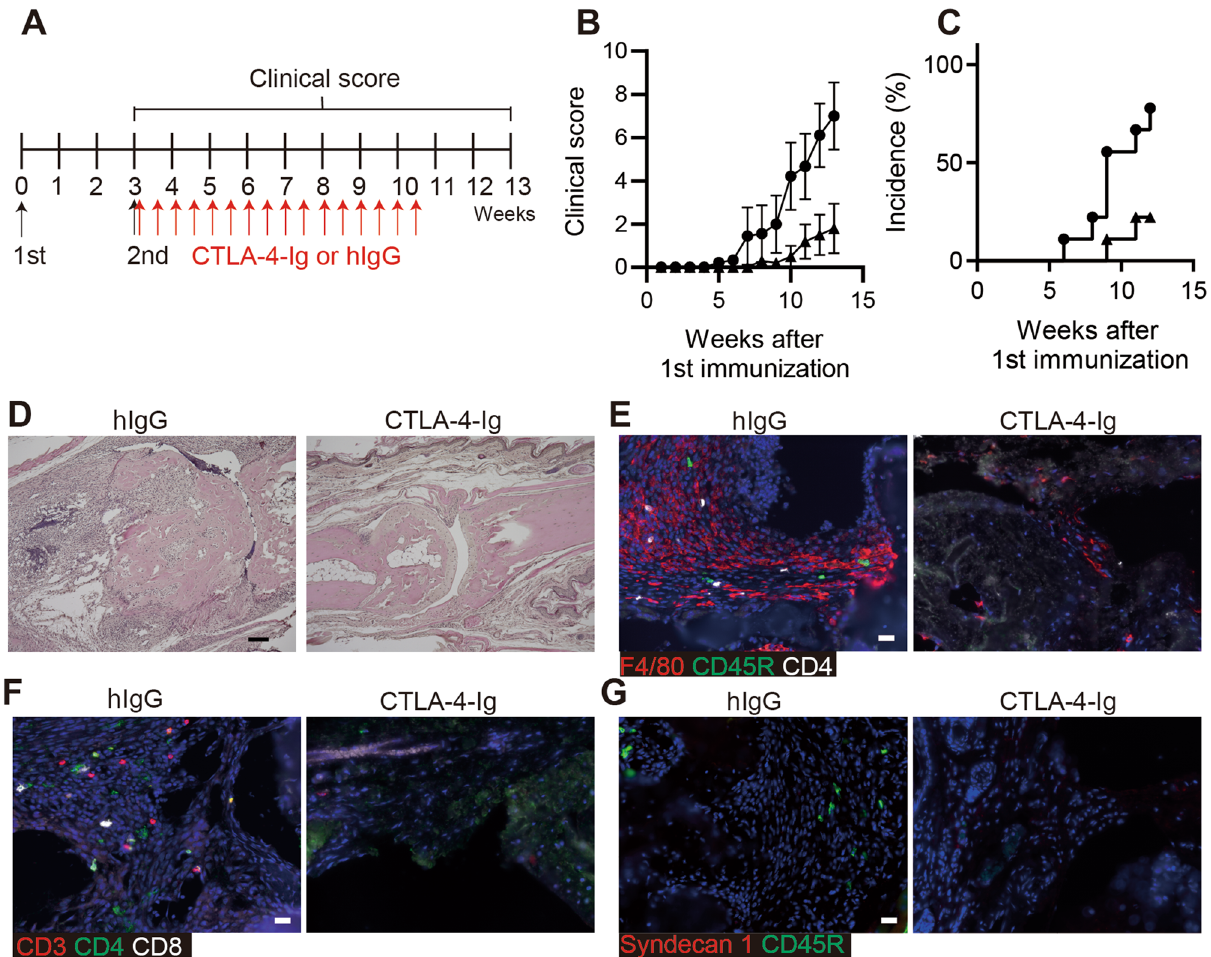
Figure 1. CTLA-4-Ig ameliorates chronic inflammatory arthritis in D1BC mice. ( A ) Schematic diagram indicating the timeline for the induction of chronic inflammatory arthritis with bColII, followed by the ip injection of CTLA-4-Ig or human IgG (hIgG) in D1BC mice. ( B , C ) The clinical score ( B ) and the percentage of incidence ( C ) of chronic inflammatory arthritis in D1BC mice treated with CTLA-4-Ig (closed triangle) and hIgG (closed circle). The clinical scores are presented as the means ± SE of ten mice. ( D ) Joints were harvested 13 weeks after the first induction and were stained by hematoxylin and eosin. ( E – G ) Immunohistochemical staining in the joints from CTLA-4-Ig or hIgG treated mice. Antibodies against F4/80 (red), CD45R (green), and CD4 (white) ( E ), CD3 (red), CD4 (green), and CD8 (white) ( F ), and syndecan-1 (red) and CD45R (green) ( G ) were used. Scale bars indicate 100 μm (black) and 20 μm